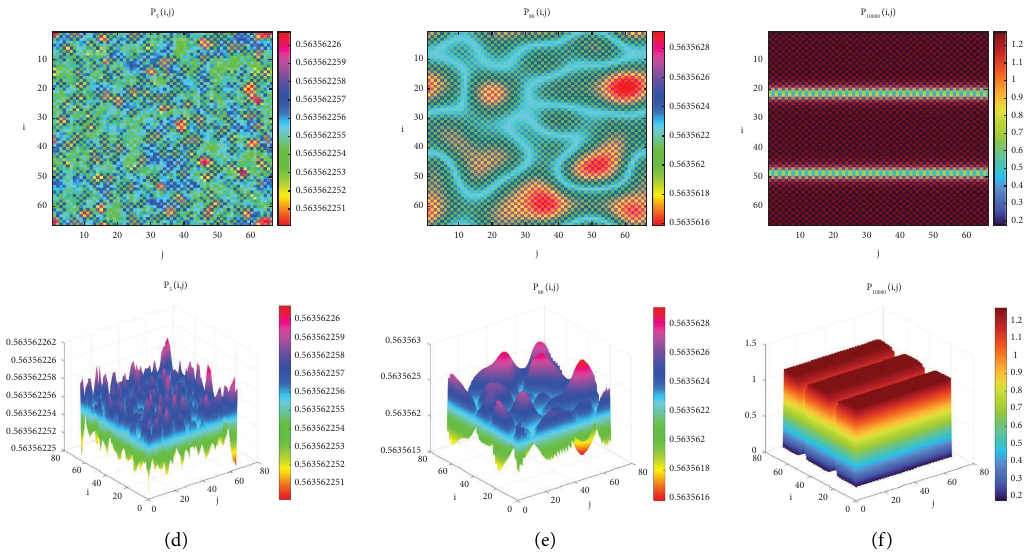
� 0 . 1, ( d , σ ) � ( 0 . 175 , 0 . 75 ) falls in the region II of Figure 8(a), which is consistent with 1 2